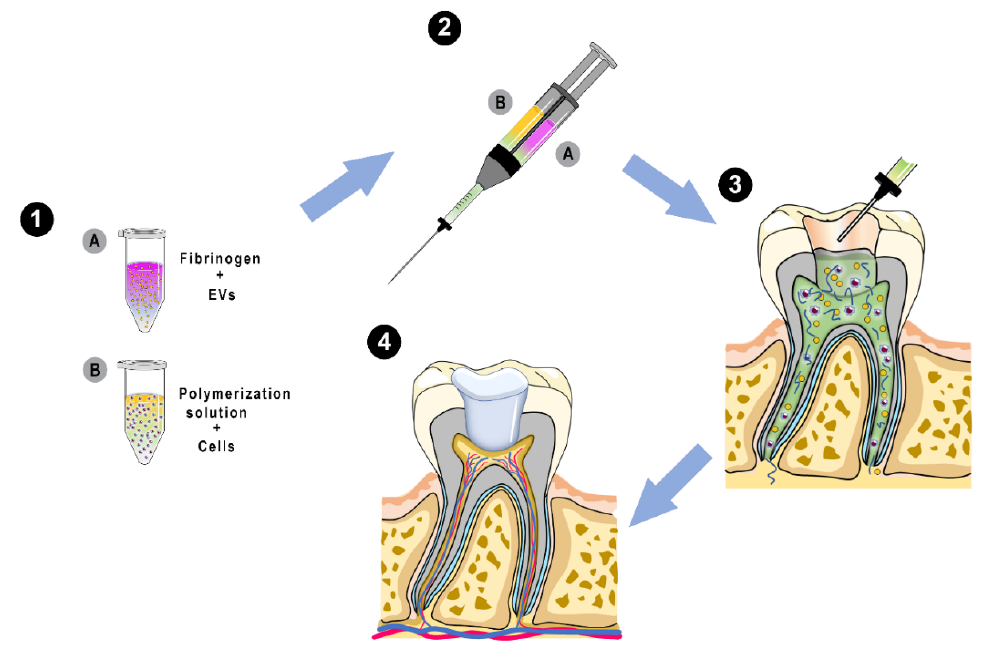
Figure 1. Schematic representation of the proposed in situ pulp tissue regeneration. ( 1 ) Preparation of the polymeric solutions for fibrin gel fabrication. Solution ( A ) includes fibrinogen and extracellular vesicles (EVs). Solution ( B ) includes polymerization solution with dental pulp stem cells (DPSCs) and human umbilical vein endothelial cell (HUVECs). ( 2 ) Co-injection of the polymeric solutions using a dual-barrel syringe. ( 3 ) Fibrin gel fits the root canal system and undergoes gelation. ( 4 ) Rapid formation of vascular networks in engineered pulp within several days.